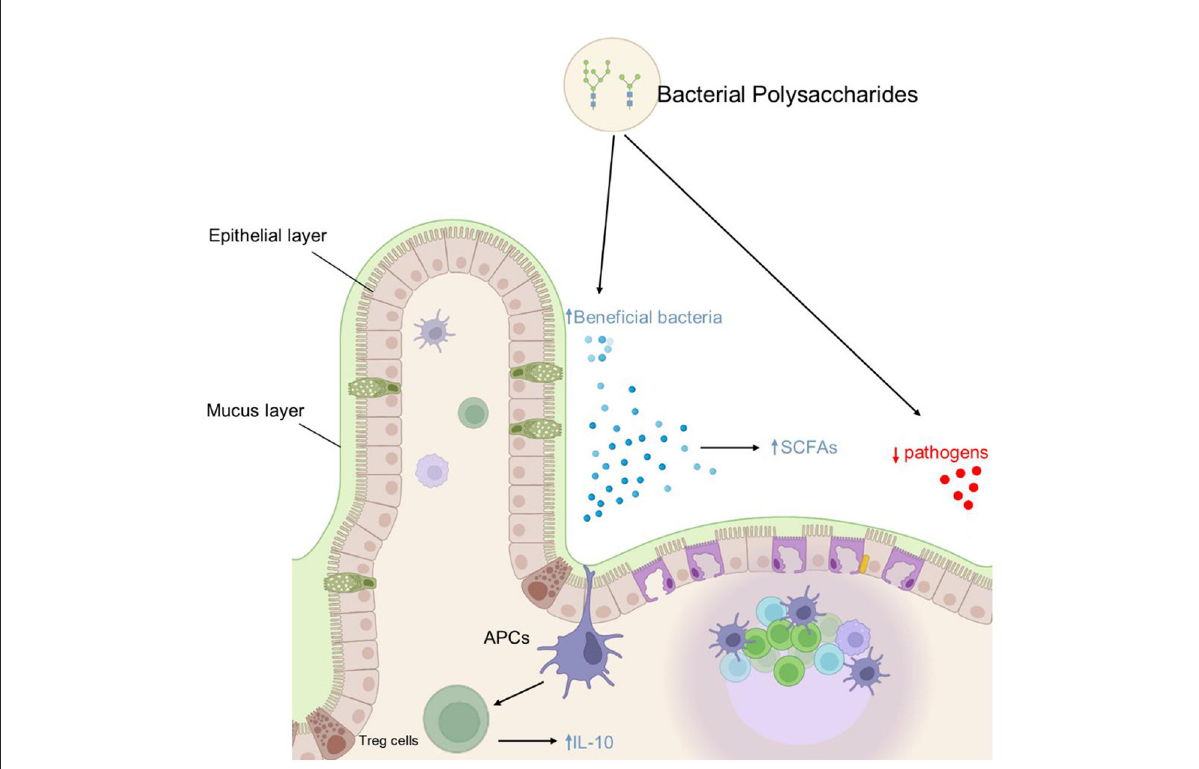
FIGURE3 Schematic diagram of anti-inflammatory and GM modulation effects of bacterial polysaccharides: polysaccharides have anti-inflammatory properties that are mediated by a variety of mechanisms, including early IL-10 induction, increased CD3 + T cell population, increased SCFA producing bacteria, and decreased potential pathogen population in the